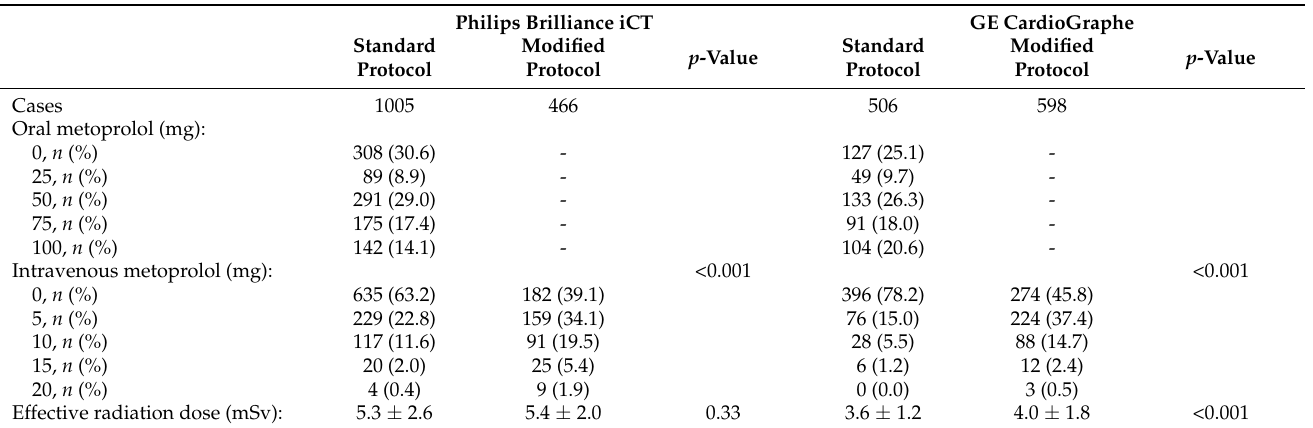
Table 2. Premedication and imaging